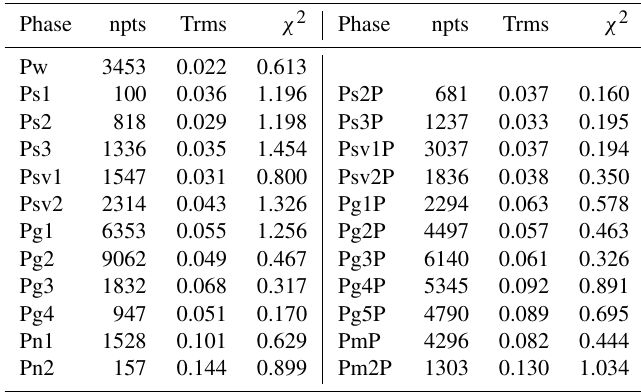
Table A1. Refracted (left) and reflected (right) phase names for MZ3 profile, number of explained events (npts), residual mean squares (Trms, in seconds), and normalized chi-squared